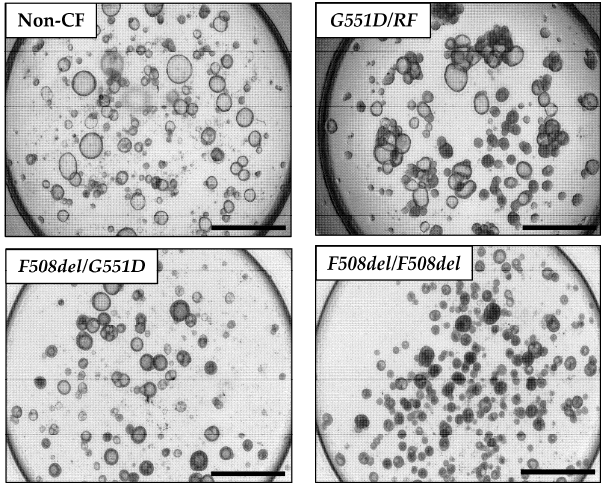
Figure 5. Light microscopy of cultures at 21 days of growth demonstrates variations in the amount of luminal fluid present within organoids of different CFTR genotypes. Scale = 1000 µm. The genotype ( G551D/unknown (MF/RF based on phenotype) is defined in Supplementary Material Table S1. Genes 2020 , 11 , x FOR PEER REVIEW